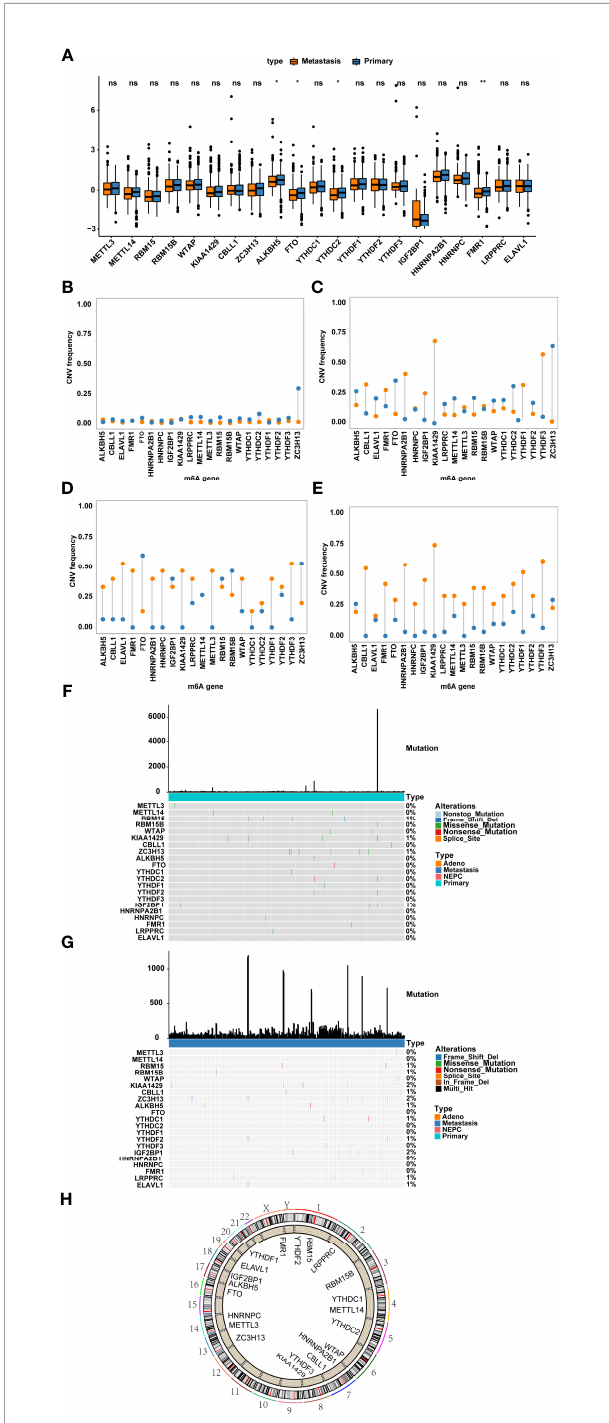
FIGURE 1 | Genetic variants of m6A regulators. (A) The expression of m6A regulator genes in nonmetastatic and metastatic prostate cancers; Frequency of CNV in m6A regulator genes in primary tumour (B) , metastatic tumour (C) , neuroendocrine prostate cancer (D) and prostate adenoma (E) were shown. Blue represents deletion, orange represents ampli fi cation. (F, G) The location of somatic mutations of m6A regulator genes in (F) primary tumour and (G) metastatic tumour. (H) The location of m6A regulator genes on chromosomes. ns represents P > 0.05, *P ≤ 0.05, **P ≤